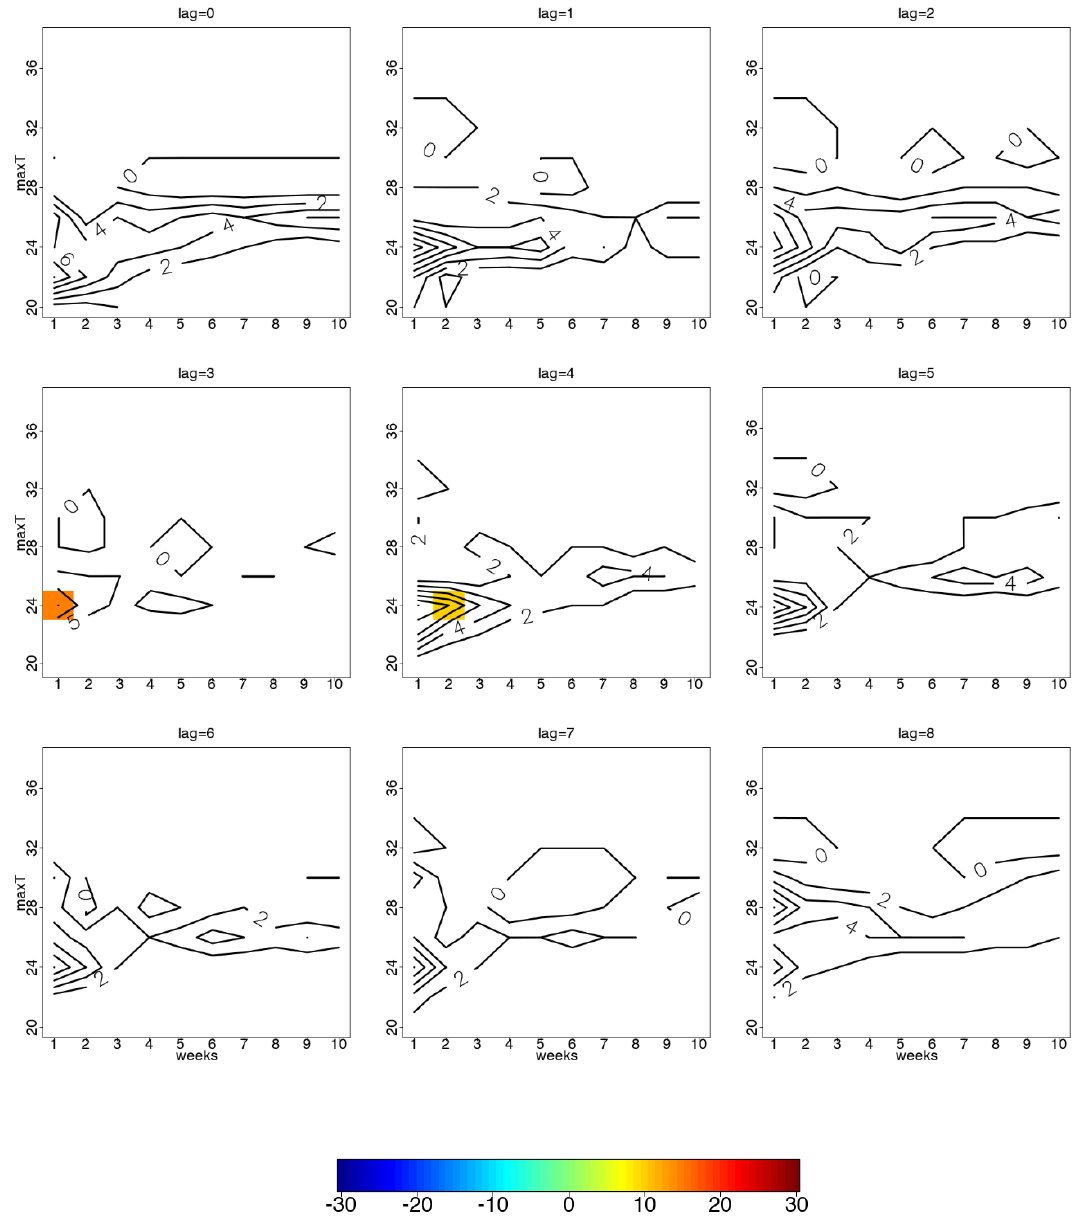
Figure 9. Statistically significant contour differences in anomalously high and low diarrhoea case counts for lag 0 to 8 weeks per consecutive weeks of maximum temperature among individuals under 5 years of age for season JJA. X-axis represents number of consecutive weeks in which the average temperature reached over Y-axis representing temperature in degrees Celsius (°C). Warm colours represent higher frequency of (X, Y) occurring when diarrhoea case counts were anomalously higher than average.